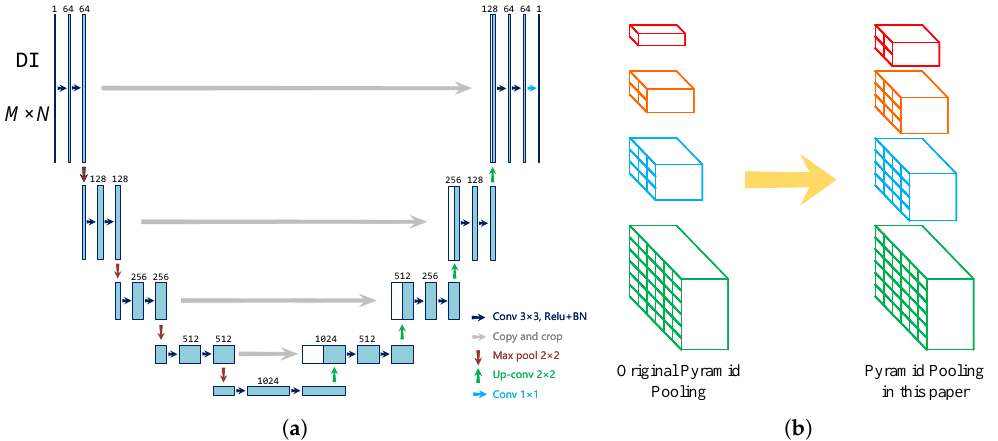
Figure 6. The Unet and PSPNet tested in this paper. ( a ) The Unet structure used in the proposed change detection method. This figure is adapted from [40]. A cyan rectangle in the figure represents the side view of a tensor and the number above the rectangle represents the number of